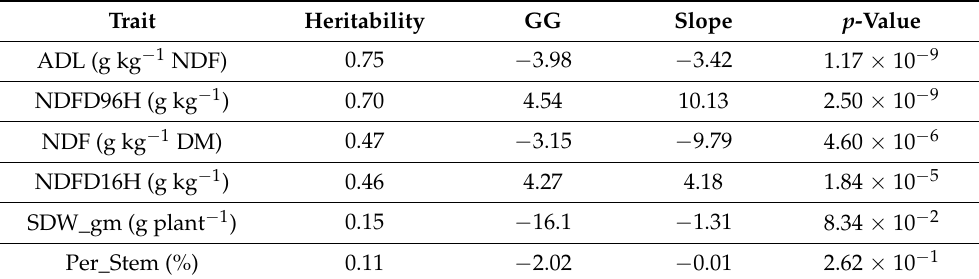
(Table 3). Selection for IVNDFD did not result in significant changes in stem dry weight or the percentage of stems ( p -values > 0.05). Table 3. Summary of heritability, genetic gain (GG), genetic regression slope, and p -values of the regression. Trait